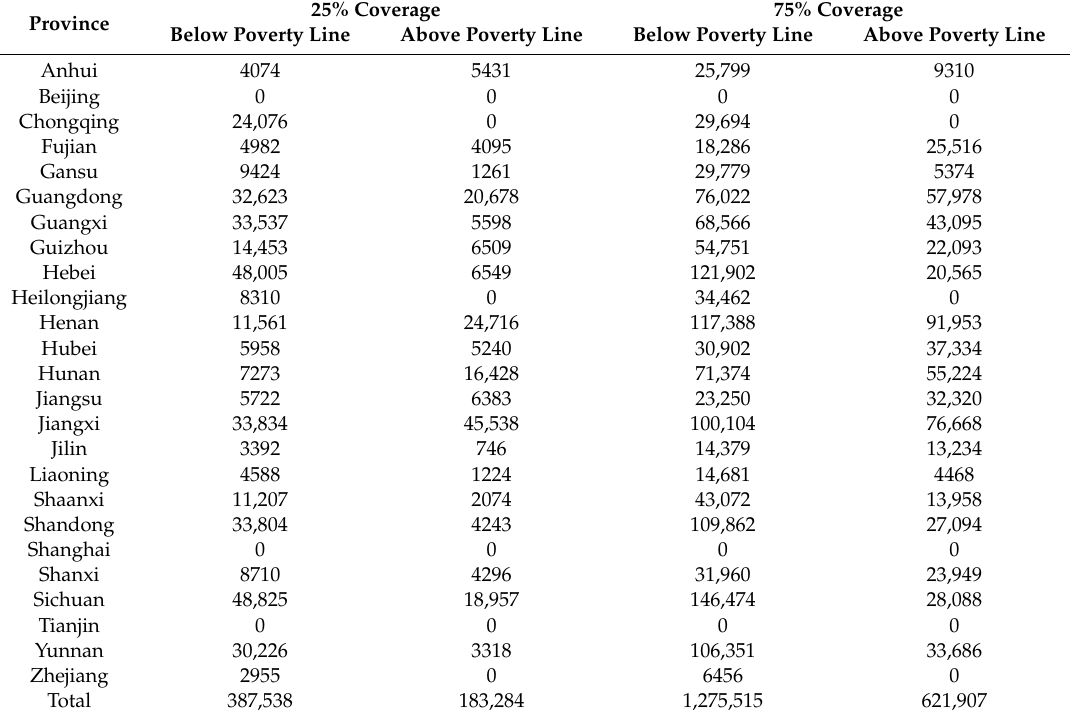
Table 1. Number of stunting cases averted by YYB program, by province and poverty status (25% and 75%